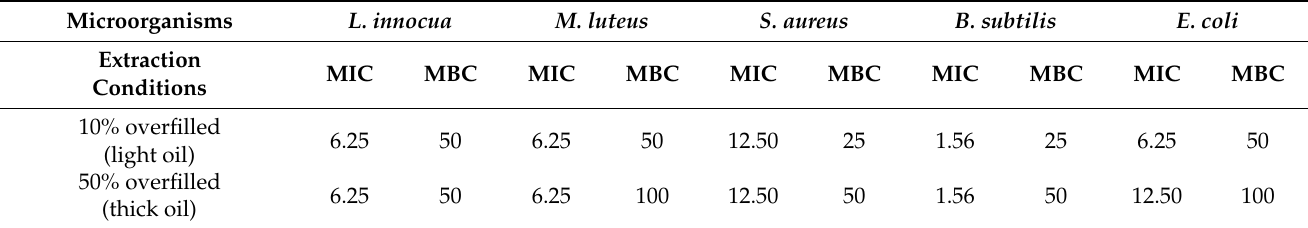
Table 1. Antimicrobial activities of jasmine essential oil from HFC-134a extraction.